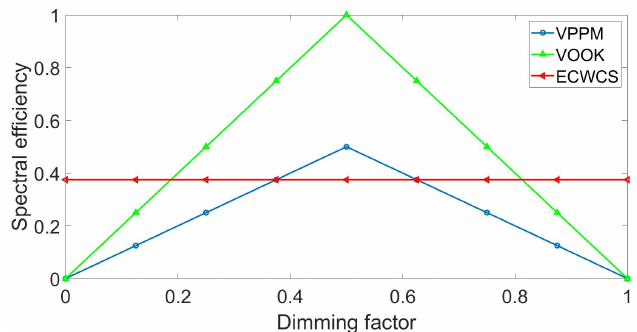
Figure 4. Spectral efficiency of variable on-off keying (VOOK), variable pulse position modulation (VPPM) and